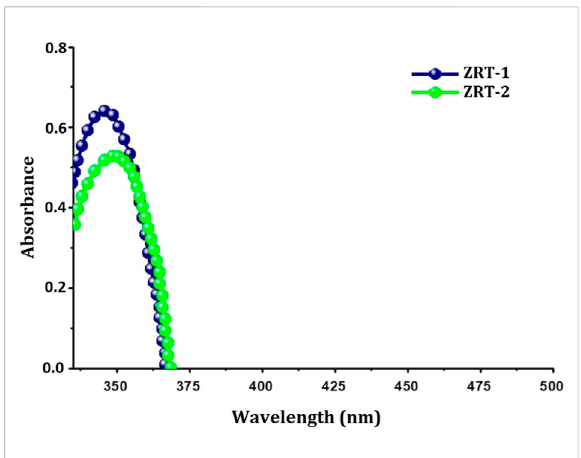
FIGURE 3 UV-Visible spectra of ZRT samples prepared by